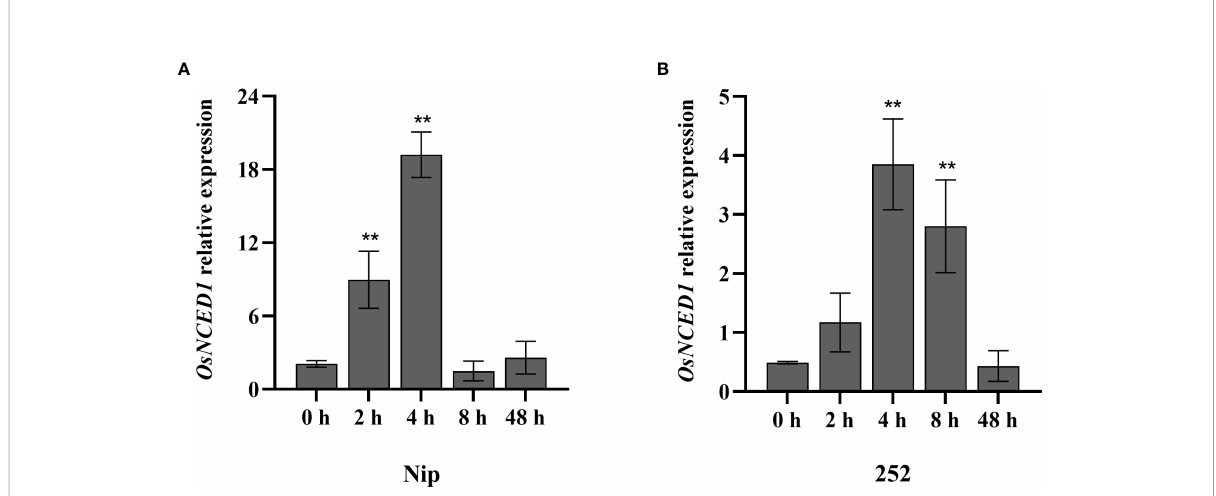
FIGURE 1 Transcript level of OsNCED1 in Nip and 252 under heat stress. (A) Transcript level of OsNCED1 in Nip under heat stress. (B) Transcript level of OsNCED1 in 252 under heat stress. Data are means ± SD (n = 3; **P < 0.01, Student ’ s t